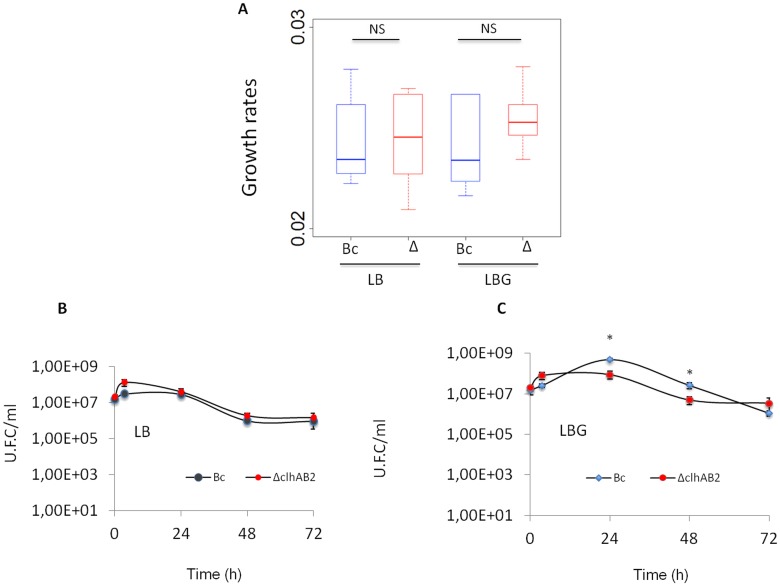
Phenotypic analyses of ΔclhAB2 isogenic mutant.(A) Box plot of growth rates in the absence (LB) or presence of 0.35% glucose (LBG). Growth rates were determined using output files of OD610 values from the microplate reader (see Materials & Methods). NS—no statistical significance. (B, C) Stationary phase survival of Bc and ΔclhAB2 isogenic mutant in LB and in LBG. Cell viability tests were performed at 0, 4, 24, 48, and 72h. Significance is based on Mann & Whitney test with a P <0.05*.